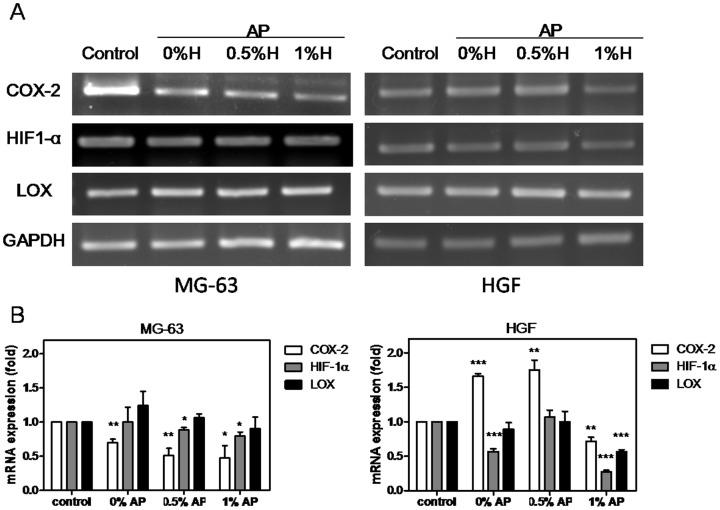
Anti-inflammation and anti-S. aureus abscess formation potential of Apexit Plus containing 0.5%–1% hinokitiol were increased.(A) The COX-2, HIF-1α, and LOX mRNA expression in MG-63 and HGF after AP, AP+0.5%H, and AP+1%H conditional medium incubated for 24 h. A normal cell culture conditional medium was used for the control. The COX-2, HIF-1α, LOX, and GAPDH expressions of MG-63 are shown in the left panel and of HGF are shown in the right panel. (B) Semi-quantitative the genes mRNA expression ratio to control in MG-63 and HGF cells. Three independent experiments were performed in triplicate. Column, mean of triplicate analysis; bars, SE. Unpaired t test. *, P<0.05; **, P<0.01; ***, P<0.001.